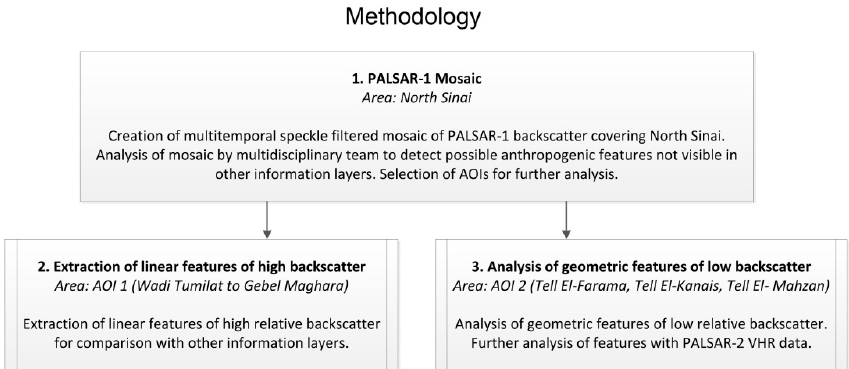
Figure 2. Diagram summarising methodological steps. Each step is described in a separate section: